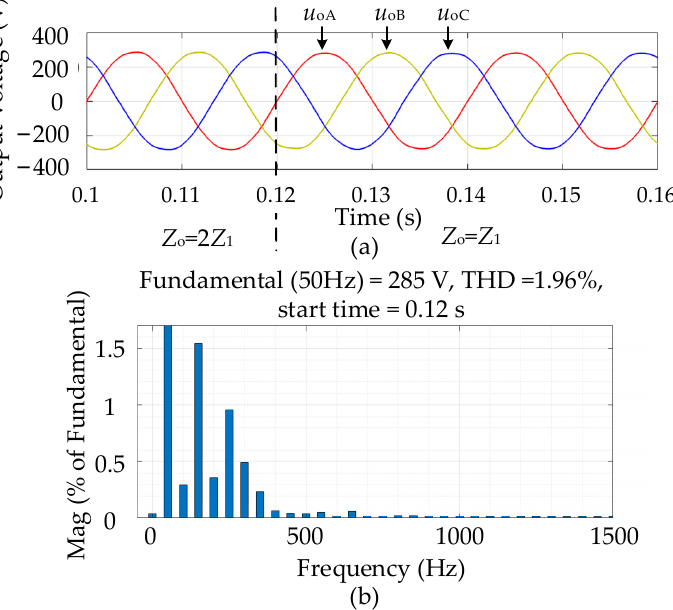
Figure 10. ( a ) The bus voltage, ( b ) DC-link capacitor voltages and ( c ) floating capacitor voltages of the A-phase during a resistive–inductive load transient.